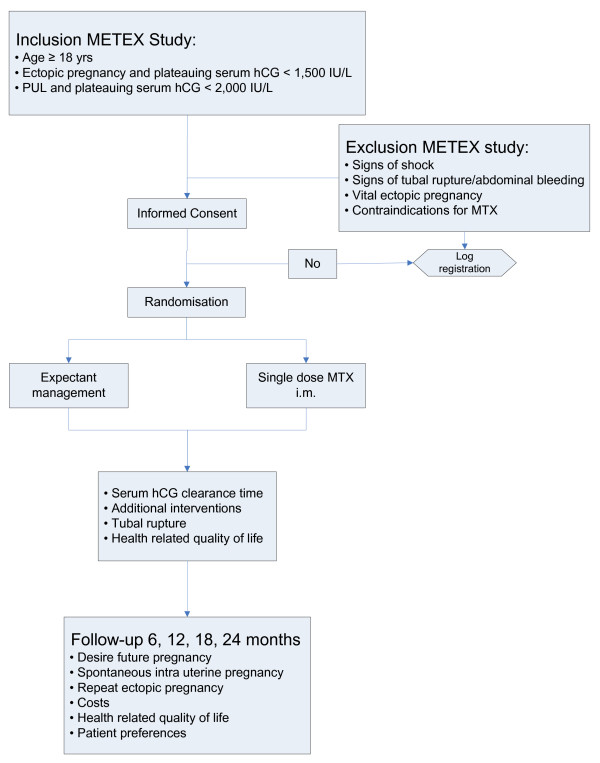
Flowchart METEX study.